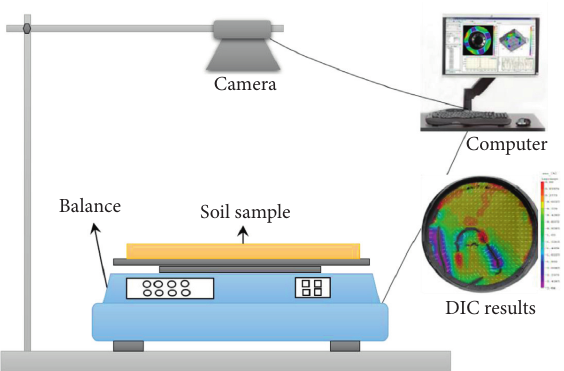
Figure 6: Diagram of experimental setup with Digital Image Correlation (DIC)